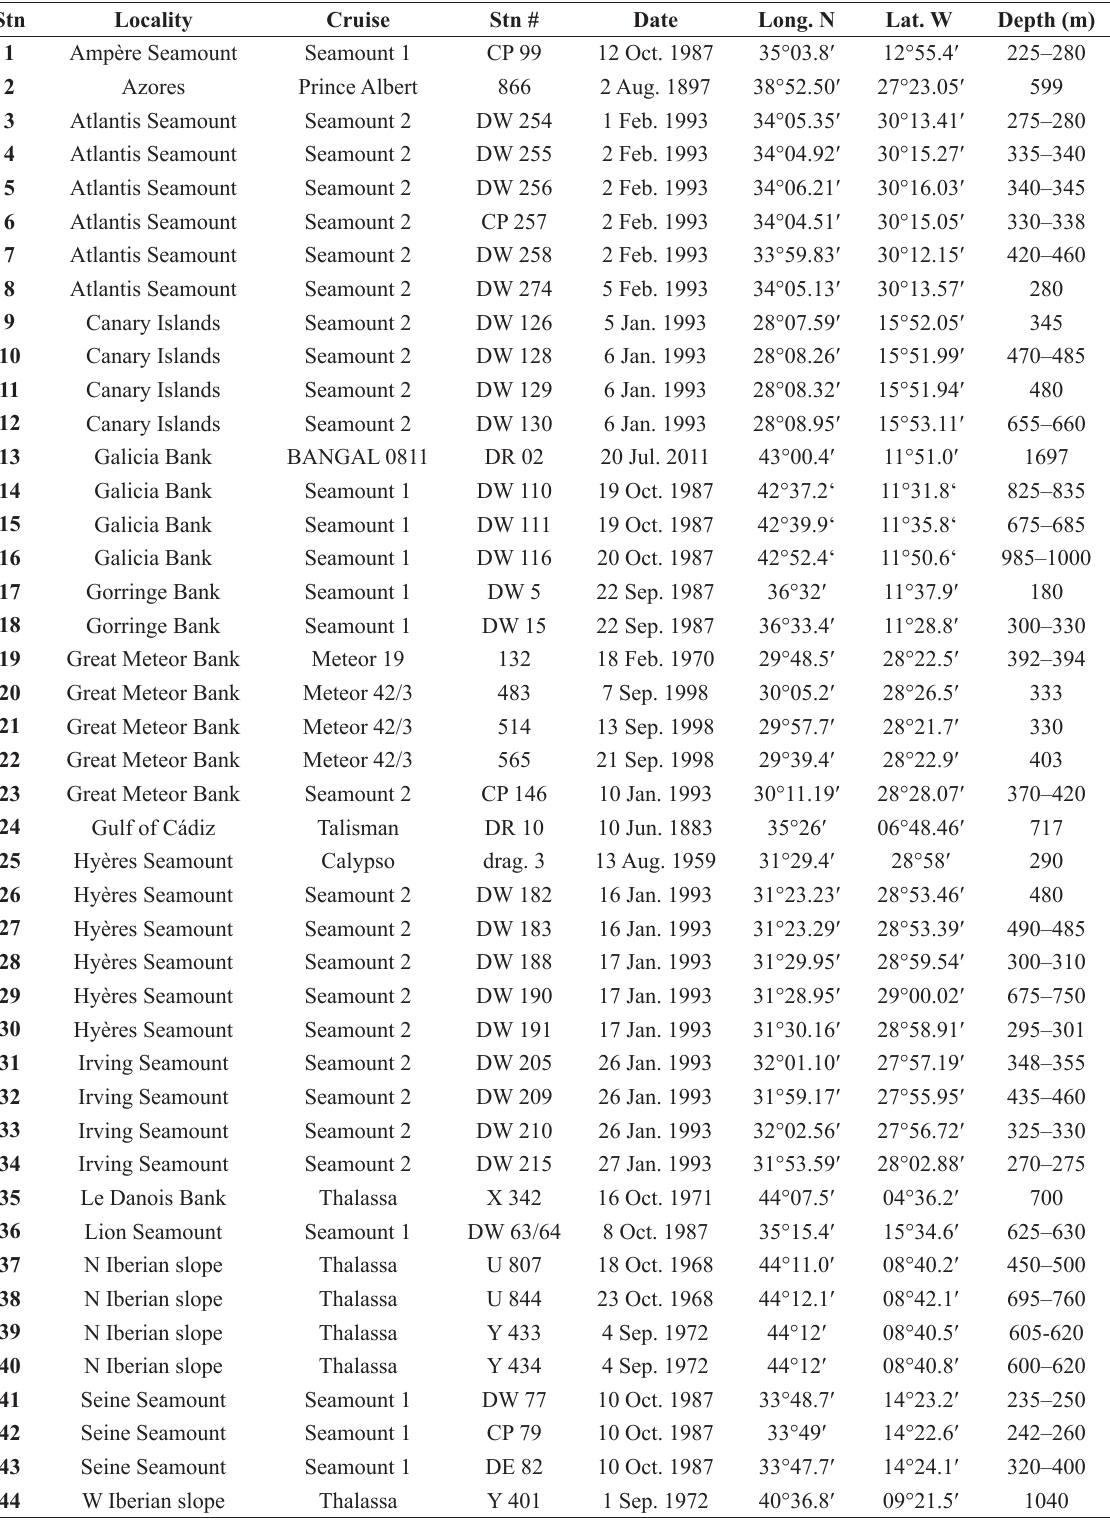
Table 1. List of sampling cruises and the respective stations (Stn #) of the material examined in this paper. The consecutive station numbers in the first column (Stn) are referenced to in the material section of the respective